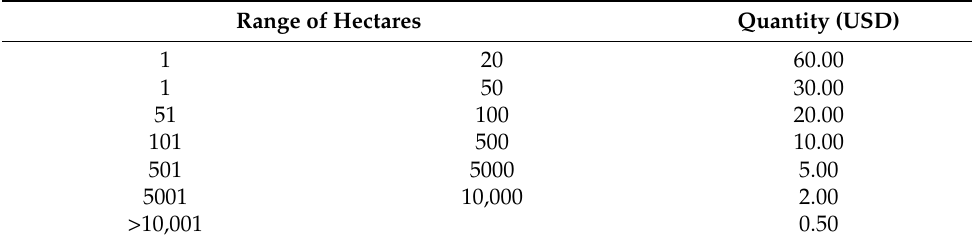
Table 8. Monetary incentive levels provided in exchange for